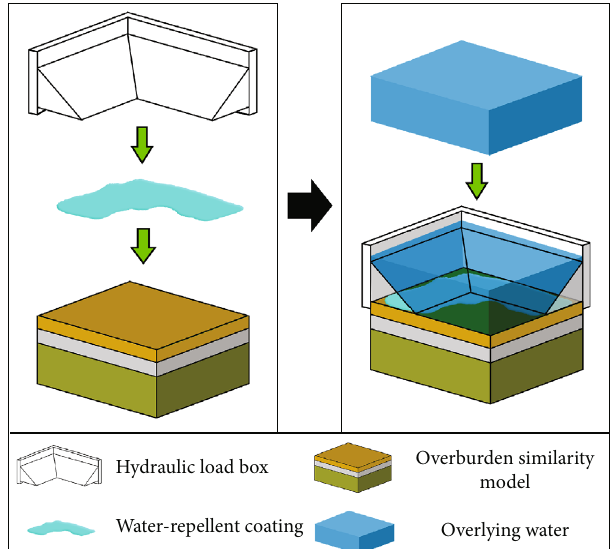
Figure 6: Leakproof treatment of model boundaries.